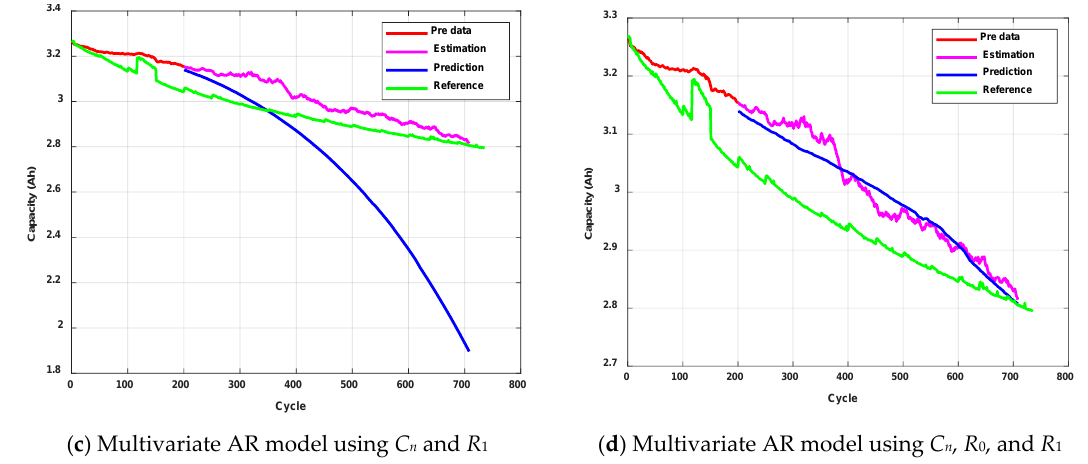
Figure 13. Capacity prediction results obtained using the AR model and DEKF (case 2).